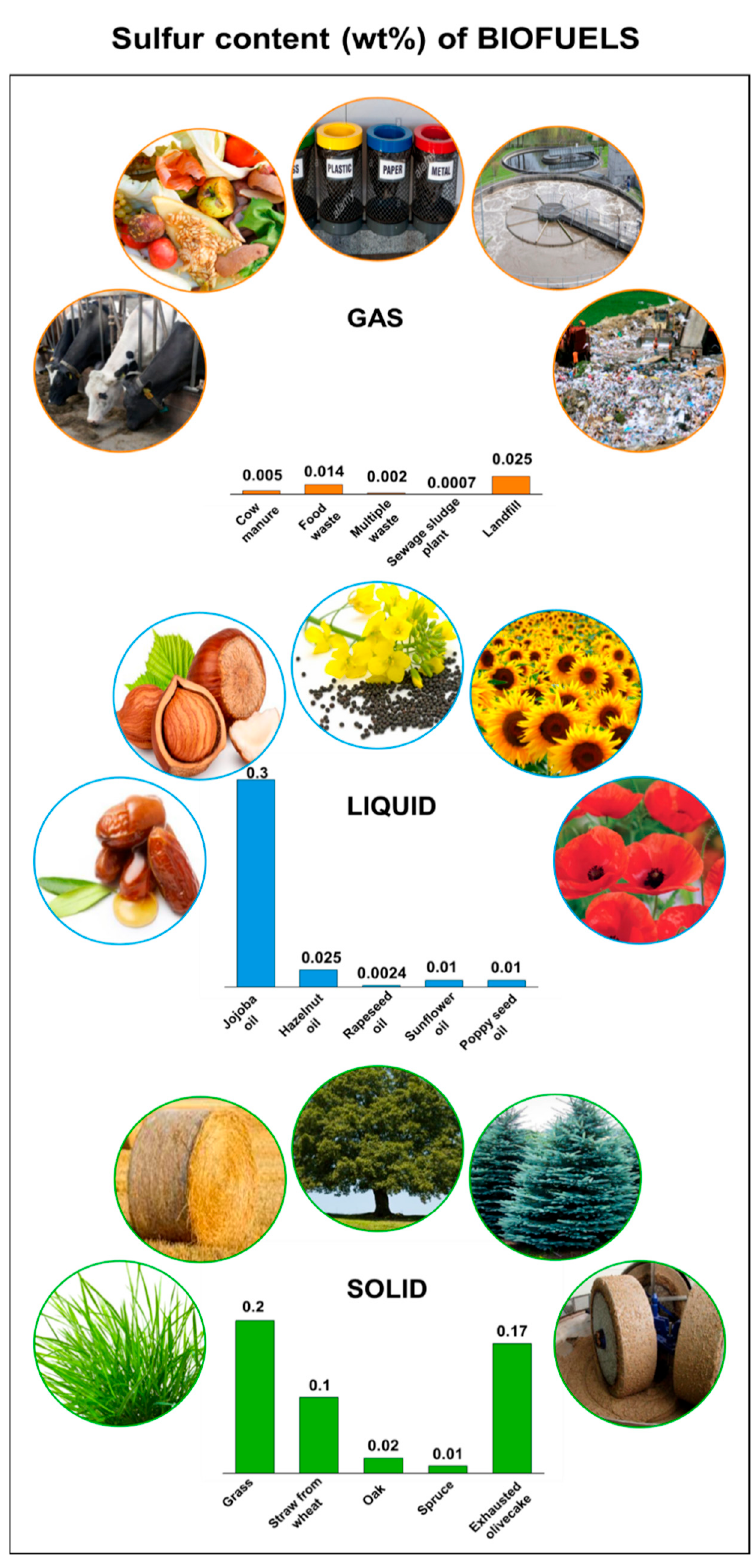
Figure 4. A few examples of s ulfur content (wt%) in solid [73,74], liquid [75,76], and gaseous [77,78]